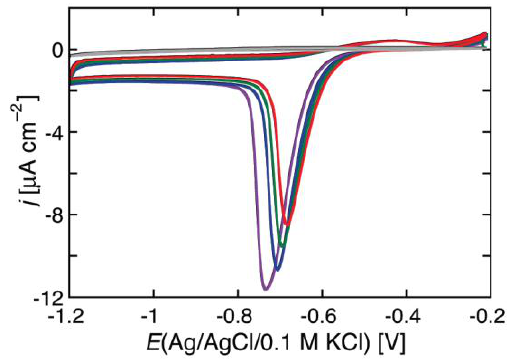
Figure 15. Cyclic voltammograms (CVs) at a DPTL/DOPC tBLM in a pH 3 solution of 0.1 M KCl, 1 × 10 −3 M HCl and 0.8 μg/mL melittin, recorded between −0.20 and −1.20 V at a scan rate of 50 mV/s. Pristine CV (purple curve) and three further CVs (blue, green and red curves) after a few potential cycles. The grey curve is the CV in the absence of melittin. (Reprinted from [19]. Copyright 2016, with permission from Elsevier).